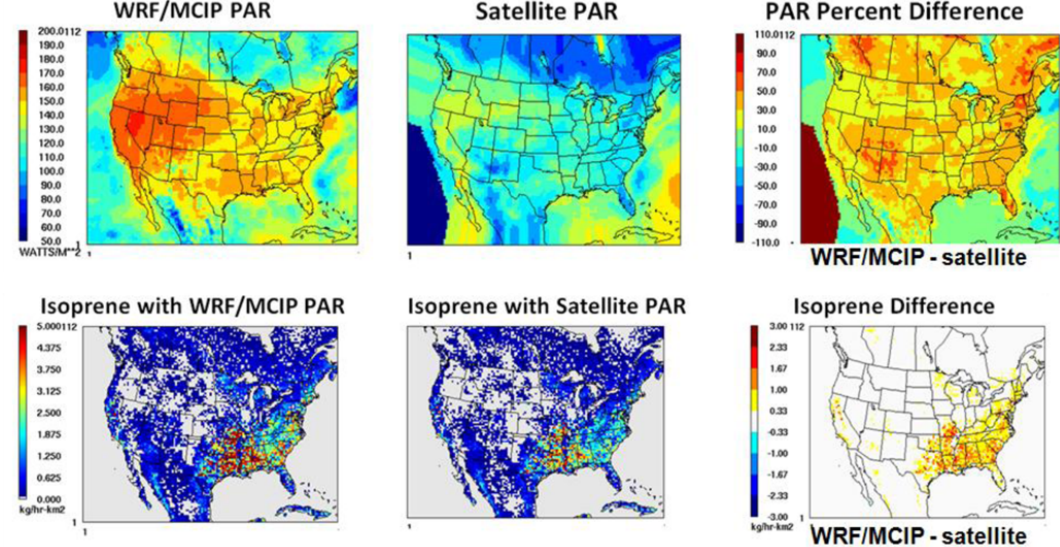
Fig. 2. 3–18 July 2008, period average estimates of PAR (Wm − 2 ) from WRF/MCIP (top left) and satellite (top middle) and percent dif- ference for WRF/MCIP – Satellite (top right) and associated isoprene emissions (kgh − 1 km − 2 ) using MEGAN2.1 in WRF-AQ driven by WRF/MCIP PAR (bottom left) and satellite PAR (bottom middle) and difference (bottom